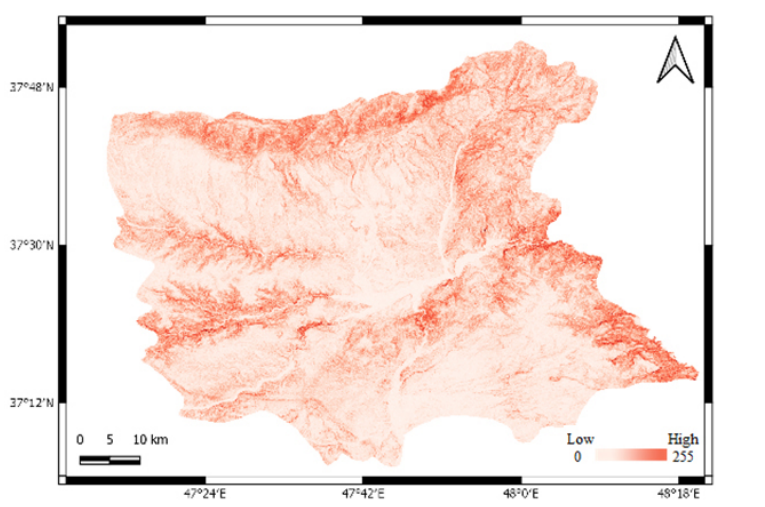
Figure 3. Soil slop